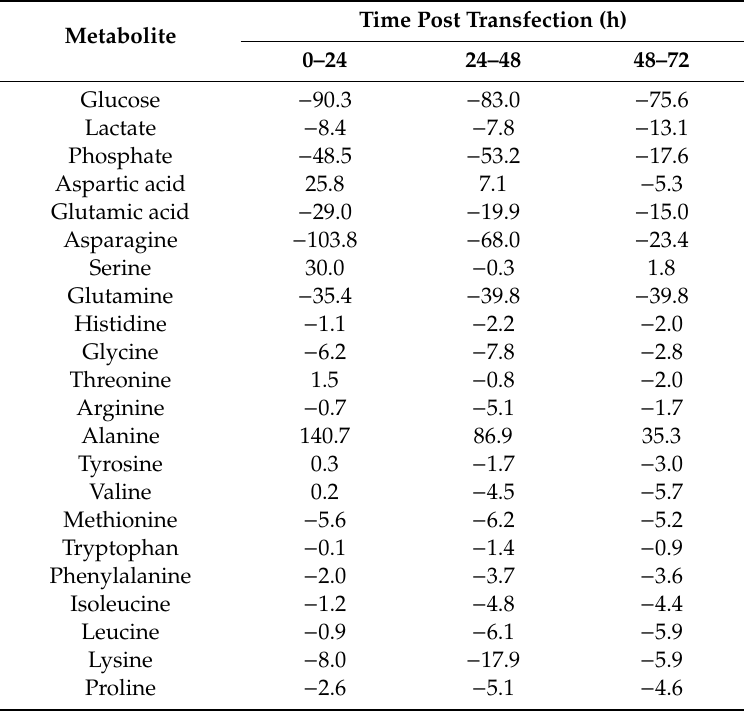
Figure 4. Consumption and production of different metabolites in transfected High Five cells at bioreactor scale. ( A , B ) Profiles of glucose and lactate ( A ) and main amino acids produced/consumed ( B ). Glu: glutamic acid; Asn: asparagine; Gln: glutamine; Ala: alanine. Table 2. Uptake and production rates of the main metabolites in High Five cells transfected at bioreactor scale for Gag-eGFP VLP production. Rates are expressed in nmol / (10 6 cell · h) and negative values indicate